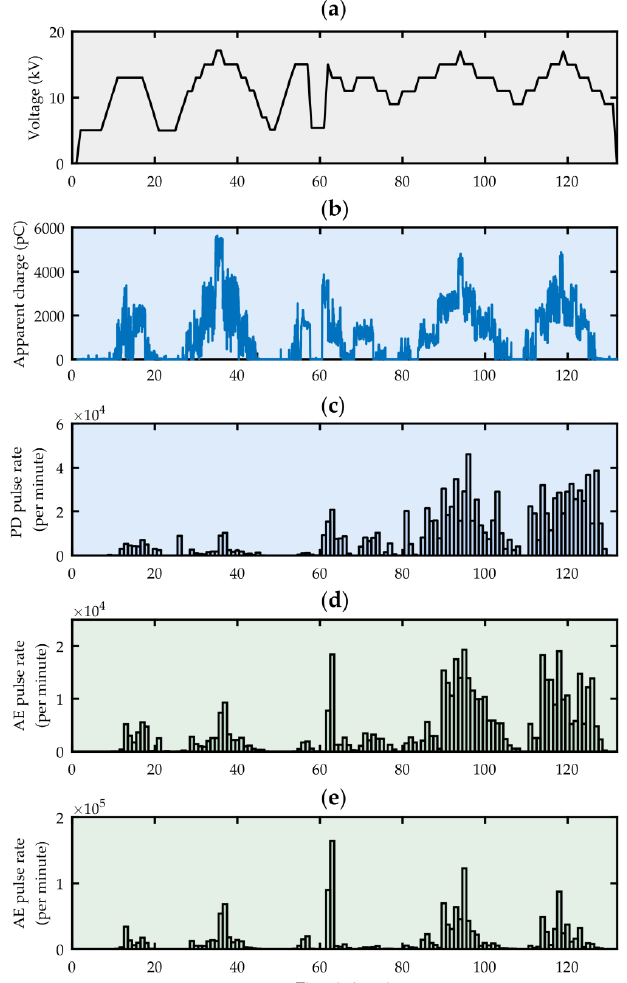
Figure 12. Test voltage value ( a ), PD apparent charge ( b ), number of PD pulses recorded by a conventional partial discharge meter PD-Smart, ( c ) number of AE pulses recorded by the reference monitoring system PDtracker Portable, ( d ) number of AE pulses registered by the tested, low-cost PD monitoring system ( e ).